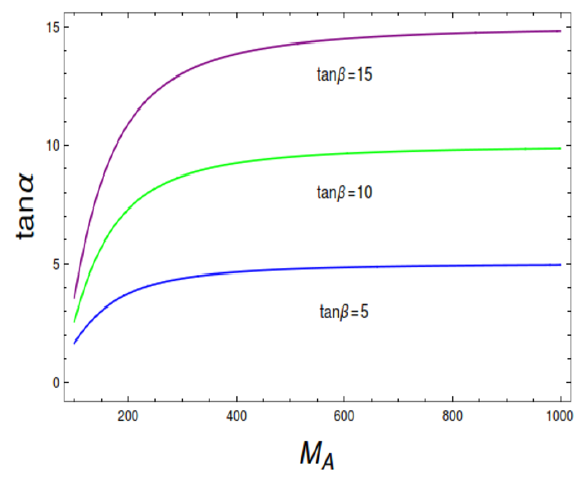
Figure 1 . tan (cid:11) versus M A where (cid:11) = (cid:25)